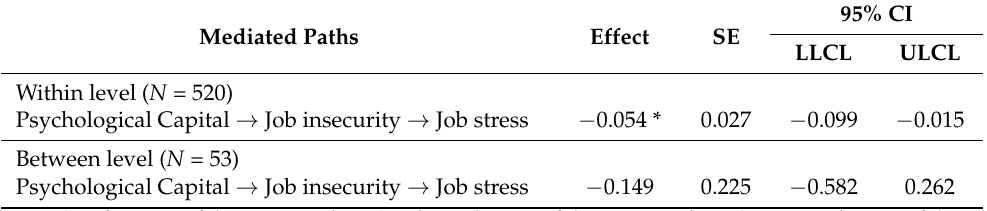
Table 5. Indirect effect results. Mediated